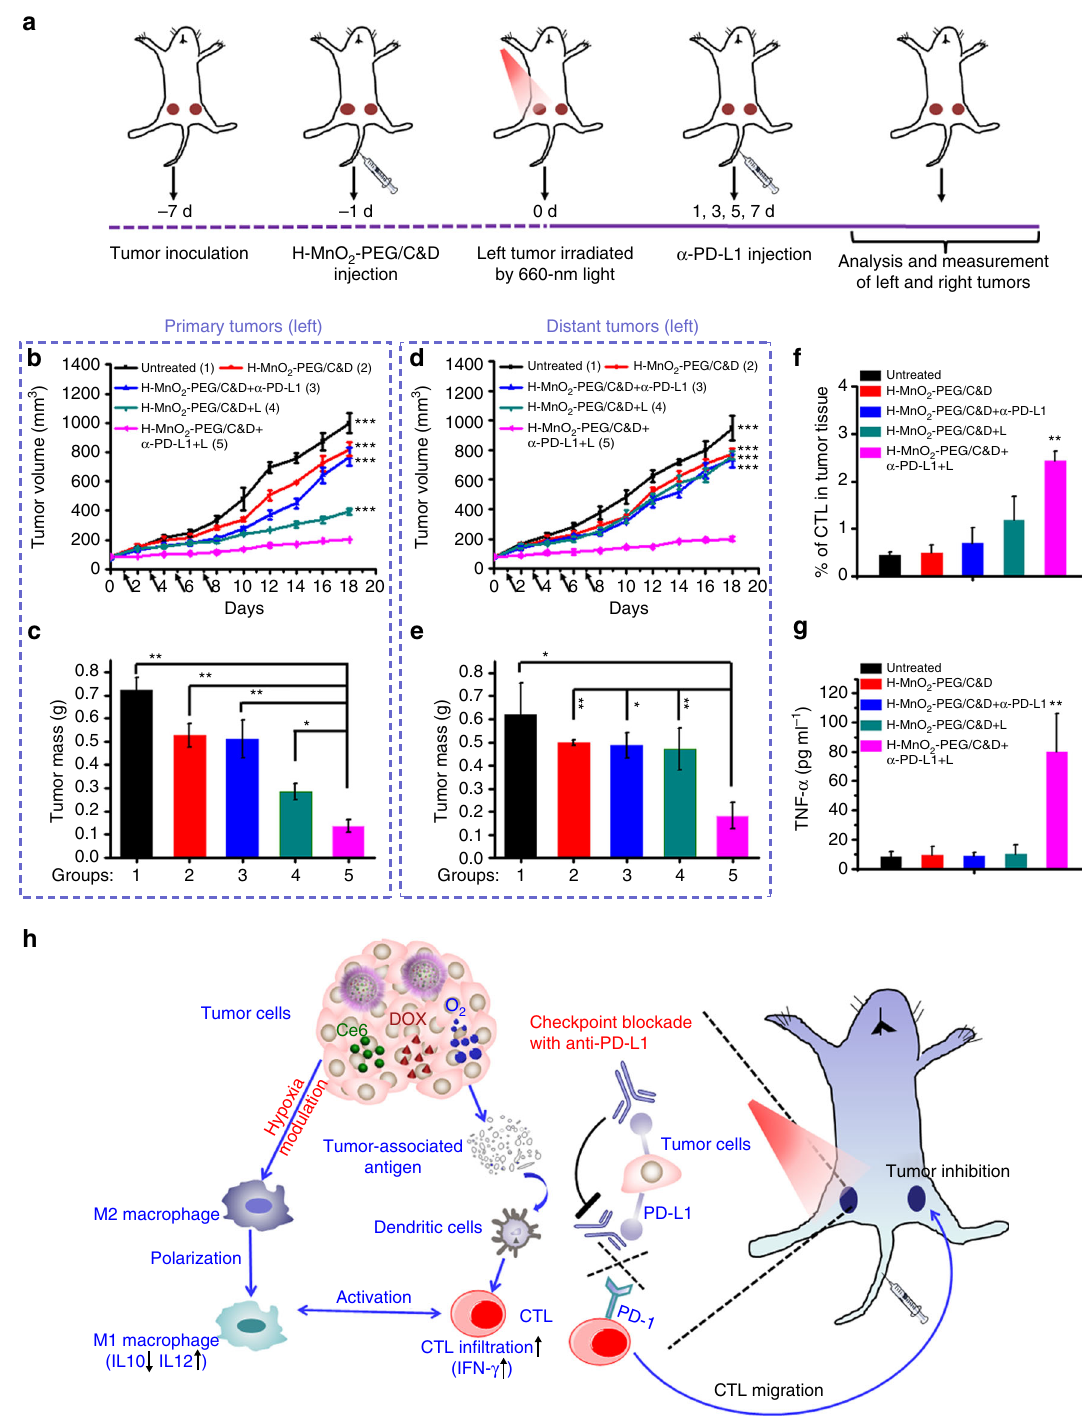
Fig. 7 The abscopal effect of H-MnO 2 -PEG/C&D in combination with anti-PD-L1 ( α -PD-L1) checkpoint blockade. a Schematic illustration of H-MnO 2 -PEG/ C&D and anti-PD-L1 combination therapy. b , d Primary ( b ) and distant ( d ) tumors growth curves of different groups of mice after various treatments indicated. Error bars are based on SEM (six mice per group). The arrows represent the time points of anti-PD-L1 administration. c , e Average weights of primary ( c ) and distant ( e ) tumors collected from mice 18 days after initiation of various treatments. f CTL in fi ltration in distant tumors. CD3 + CD8 + cells were de fi ned as CTLs. g The production of TNF- α in sera of mice determined on the 9th day post various treatments. h The proposed mechanism of anti-tumor immune responses induced by H-MnO 2 -PEG/C&D in combination with anti-PD-L1 therapy. p values were calculated by Tukey ’ s post-test (*** p < 0.001, ** p < 0.01, or * p <